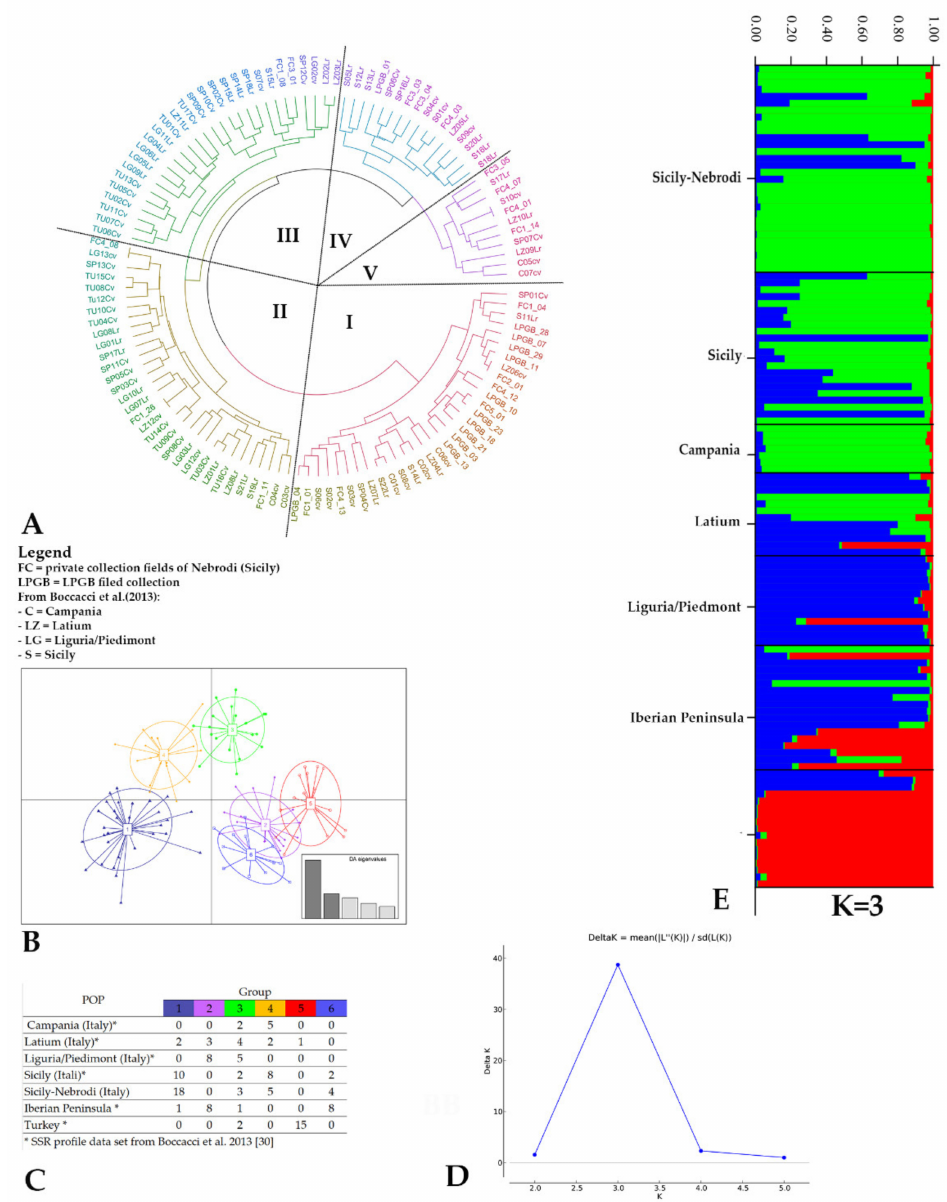
Figure 3. ( A ) UPGMA dendrogram obtained from Italian, Iberian Peninsula, and Turkish genotypes, investigated by Boccacci et al. [28], and the 30 genotypes sampled in Nebrodi Mountains (Sicily, Italy) based on 8 SSR loci and Bruvo’s distance. ( B ) Discriminant analysis of principal components (DAPC) scatter plot. Dots represent individuals, and the scatterplot shows only the first two PCs from the DAPC. ( C ) Group memberships and group sizes obtained from DAPC analysis. ( D ) Delta K according to Evanno et al. 2005. ( E ) STRUCTURE analysis by Bayesian structuring (using STRUCTURE 2.3.4, with a burn-in phase of 10,000 iterations followed by 100,000 MCMC repetitions). Inferred ancestries of 30 genotypes from the Nebrodi area and Italian, Iberian Peninsula, and Turkish germplasm based on 3 genetic groups. Each individual is represented by a vertical colored line. Different colors of each column depict the percent of membership (vertical values on the left of the cluster) of each genotype for four